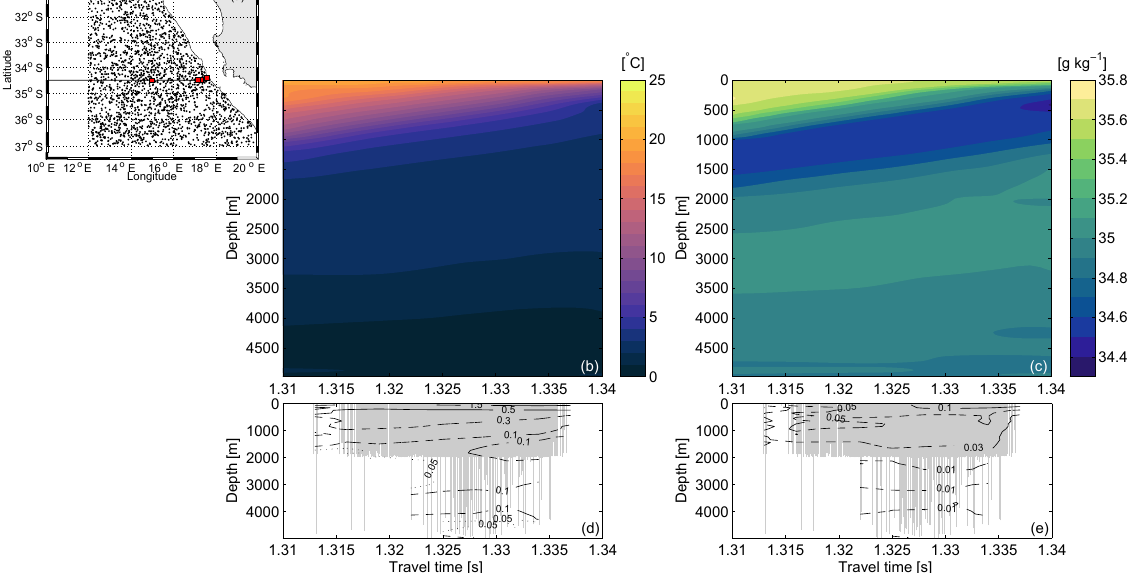
Figure 2. (a) Positions of the CTD and Argo casts from 1983 to 2018 collected around the SAMBA-east transect and used to create the GEM field. The CPIES are identified by the red squares along the transect. Gravest empirical mode (GEM) fields of conservative temperature (b) and absolute salinity (c) determined for the SAMBA-east line. The root-mean-squared (rms) differences between the original hydrographic measurements and the smoothed look-up table values are shown in the lower plots (d, e) . The solid, dashed and dotted contours represent progressively smaller contour intervals. The gray vertical lines show the locations of the hydrographic